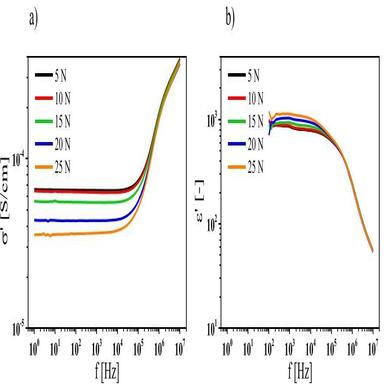
Real part of the complex conductivity (a) and complex permittivity (b) as a function of electrical frequency by varying dynamic load from 5 N to 25 N.